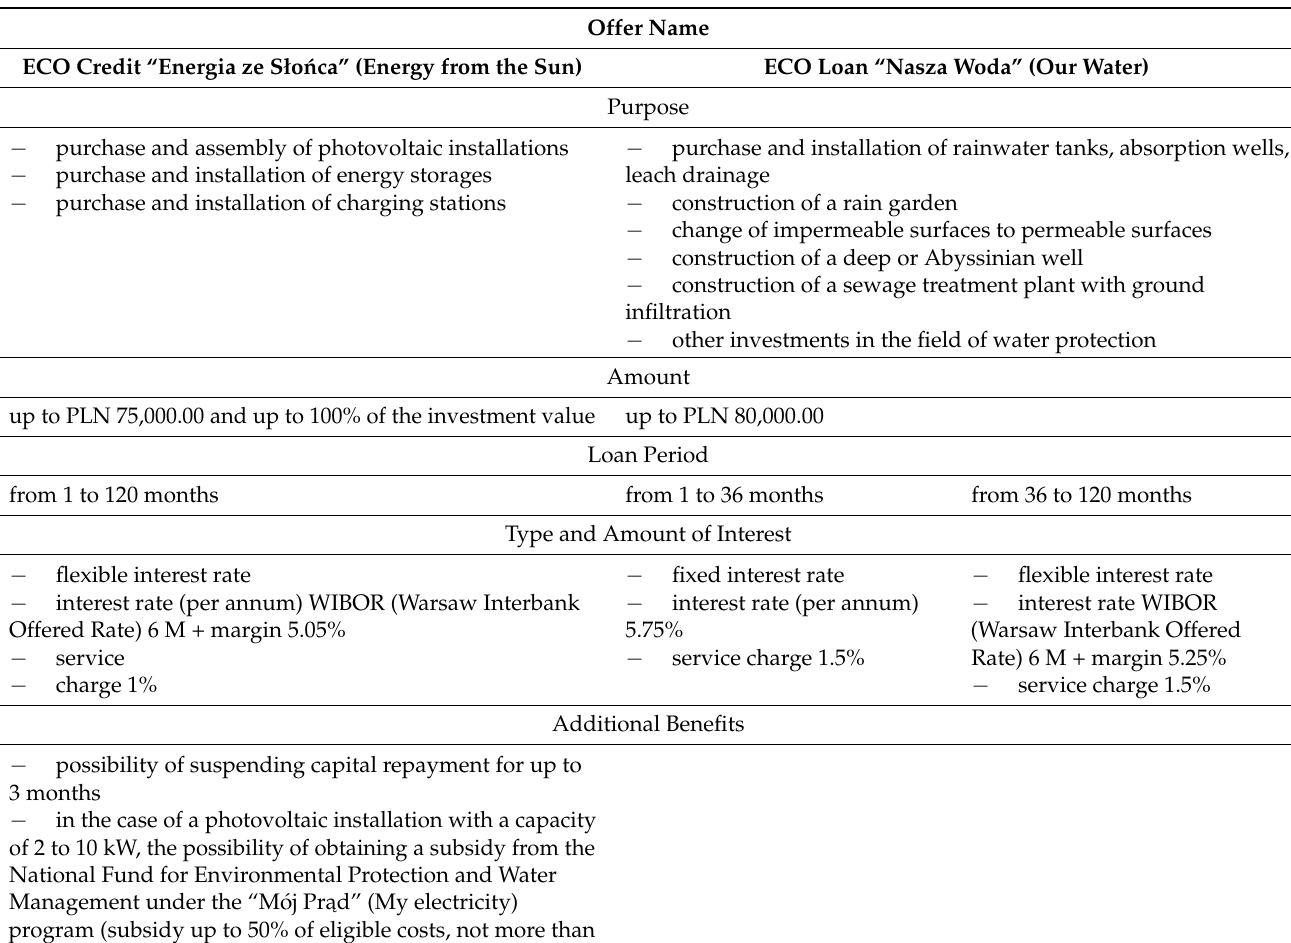
Table 1. An example of financing conditions for pro-ecological projects depending on their specificity by BO´S in Warsaw, Poland. Source: designed by authors using